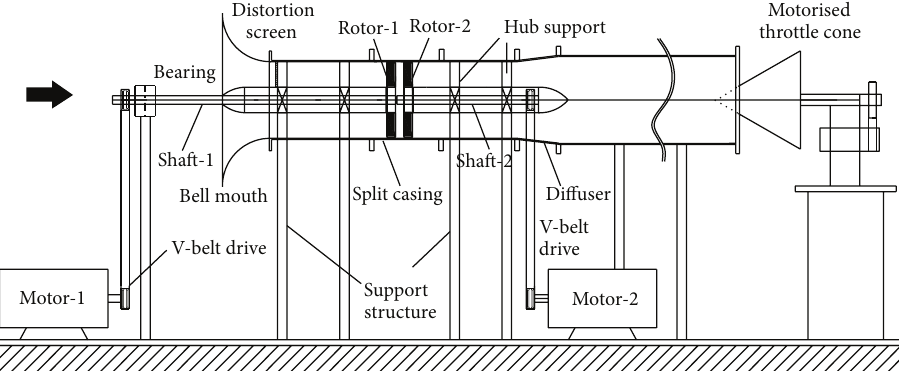
Figure 1: Experimental setup with distortion screen.